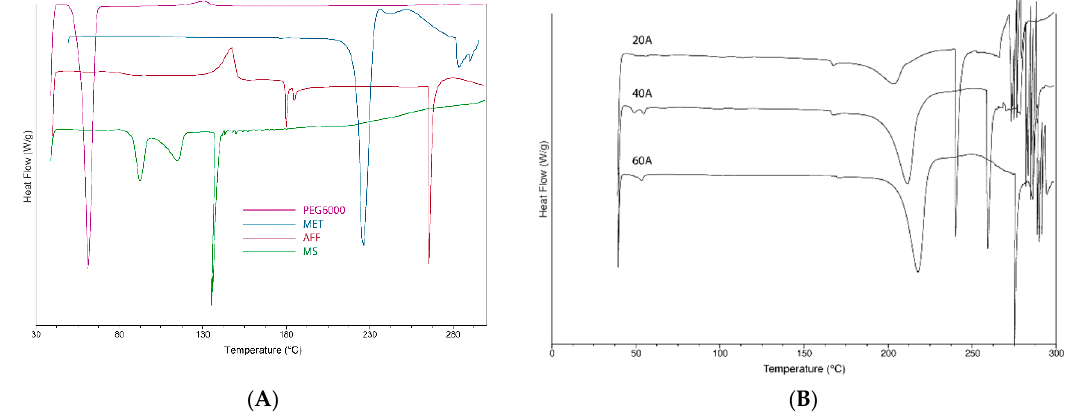
Figure 7. DSC thermograms of ( A ) pure materials, ( B ) drug-loaded filaments.